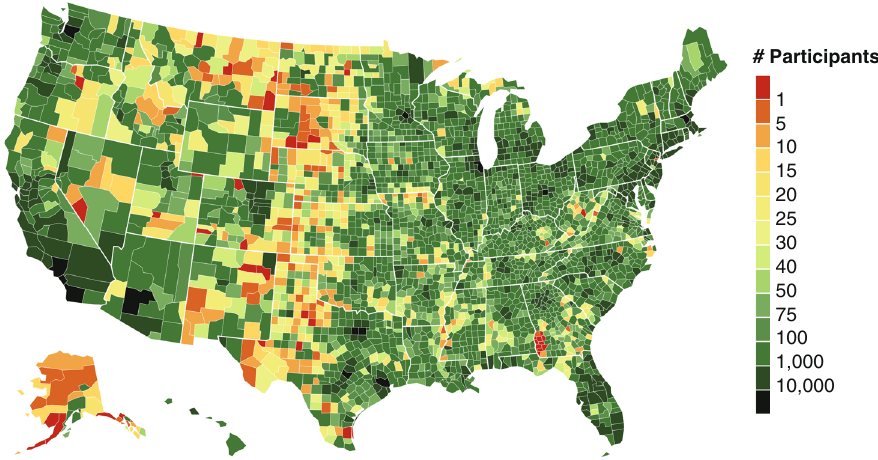
Fig. 1 Number of participants in our study across U.S. counties. A choropleth showing the number of participants in each U.S. county. This country-wide observational study included 1,164,926 participants across 9822 U.S. zip codes that collectively logged 2.3 billion food entries for an average of 197 days each. This study constitutes the largest nationwide study examining the relationship between food environment and diet to date (e.g., with 511% more counties represented compared to BRFSS data 93